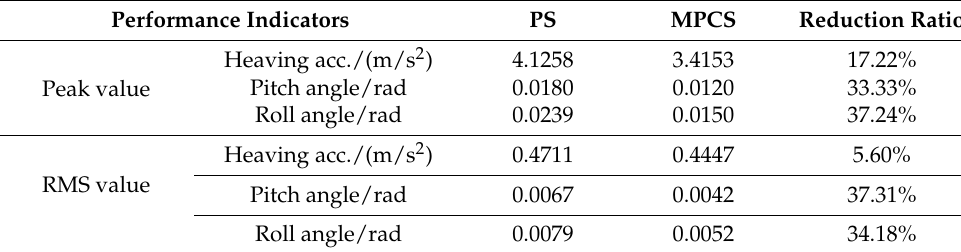
Figure 13. Experimental results of LQR under bump road disturbances: ( a ) Heaving acceleration of car body; ( b ) Pitching angle of car body; ( c ) Rolling angle of car body. Table 7. Experimental Results of Peak Value and RMS Value Under Bump Road